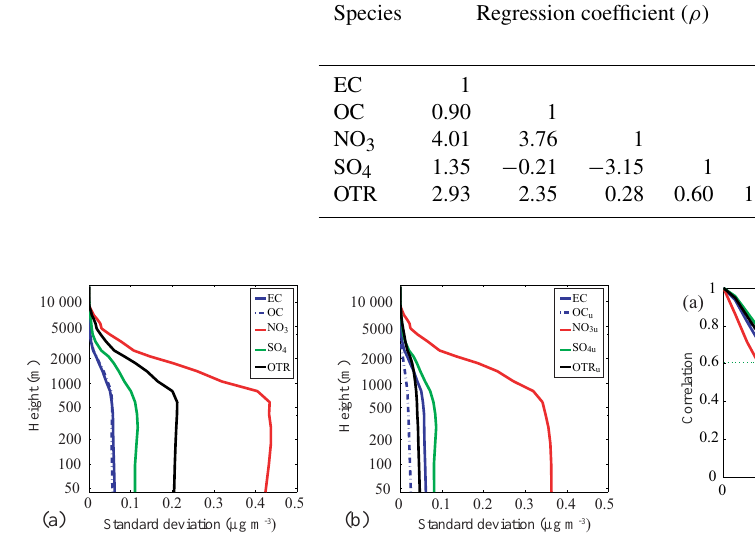
Figure 5. Same as Fig. 4, with the exception of the horizontal auto- correlation curves of the variables. The horizontal thin line is the 1 reference line of e − 2 ( ≈ 0 . 61 ) for determining the horizontal cor- relation scales. data assimilation system, but not estimated from a approx- imately alternative function. Because it is only an n z × n z and C u z for the full variables (left column) and the unbal- anced variables (right column), respectively. A common fea- ture of both the full variables and the unbalanced variables is the significant correlation between the levels of the bound- ary layer height, which is consistent with the profile of the standard deviation in Fig. 4. Some weak adjustments to the correlations between the full and unbalanced variables are made. For example, the correlation of NO 3u is stronger than the correlation of NO 3 between the boundary layers. Com- pared with the analysis of horizontal correlation scale, the vertical correlation scale of NO 3u is larger than the vertical correlation scale of NO 3 . Conversely, the vertical correlation scale of OTR u is smaller than the vertical correlation scale of OTR. These results demonstrate that the vertical correla- tions for the unbalanced variables are more consistent than the vertical correlations of the full variables, which is similar to the adjustments to the horizontal correlation scale. Note that the differences in vertical correlation are slight, com- pared with those of horizontal correlation. The main reason is that the vertical correlations are generally affected by the atmospheric boundary layer height. Thus, all vertical correla- tion decreases rapidly for the levels above the boundary layer